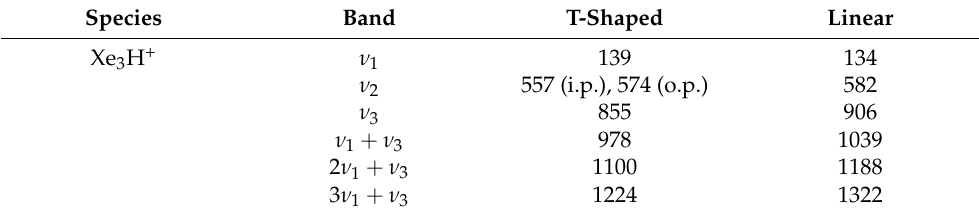
i.p. = in-plane, o.p. = out-of-plane. a Adapted with permission from Ref. [59]. Copyright 2020 American Chemical Society.